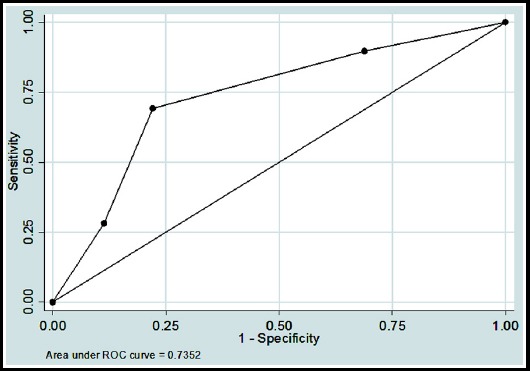
Receiver operation characteristic (ROC) curve of BISAP scores in predicting SAP.